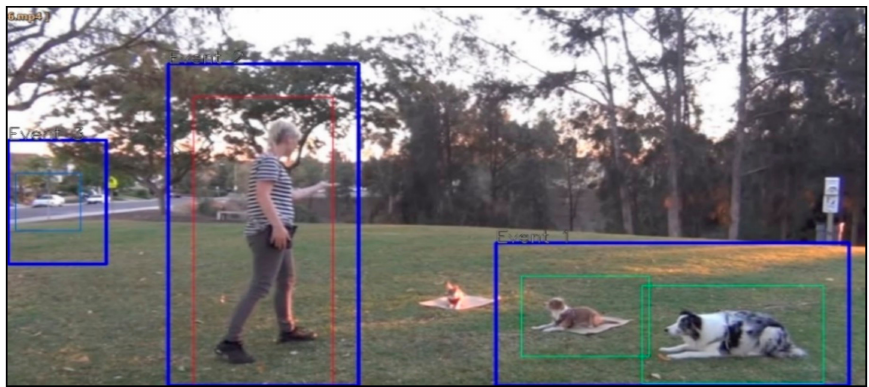
Figure 8. Faster-RCNN based event area integration algorithm results.